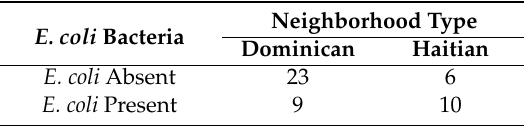
Table 2. Presence of E. coli bacteria in water